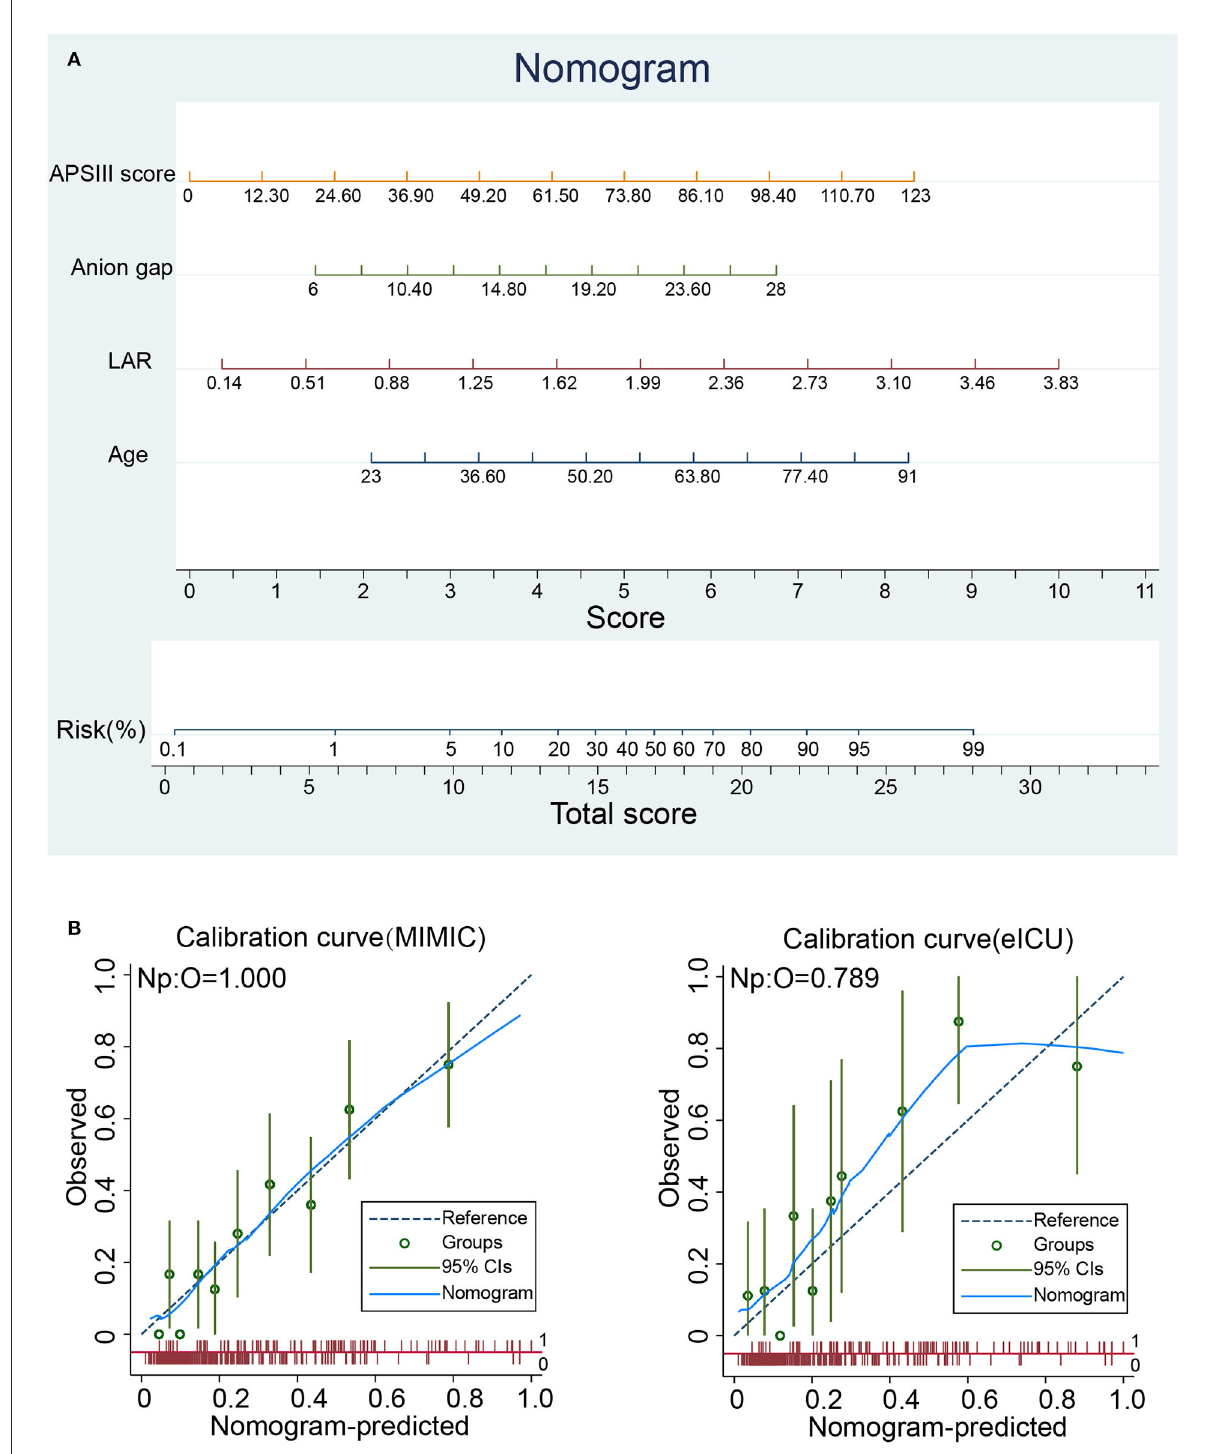
FIGURE2 Nomogram analyses of patients with spontaneous SAH. (A) Nomogram for predicting in-hospital mortality of patients with spontaneous SAH. (B) Calibration curve of the nomogram predicting in-hospital mortality in the training and validation cohorts. APSIII, Acute Physiology Score III; LAR, lactate-to-albumin